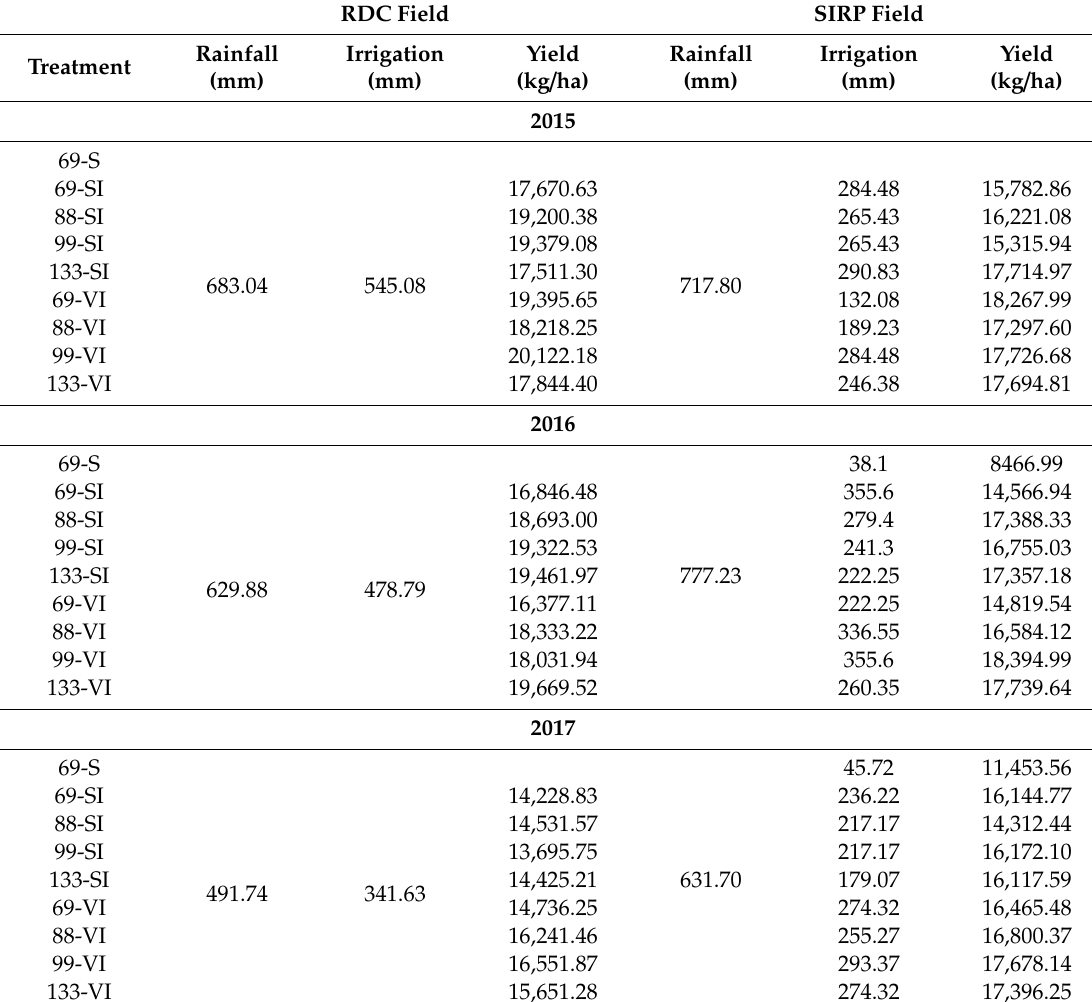
Table 3. Rainfall, irrigation and yield results for 2015, 2016, and 2017 growing seasons in RDC and SIRP